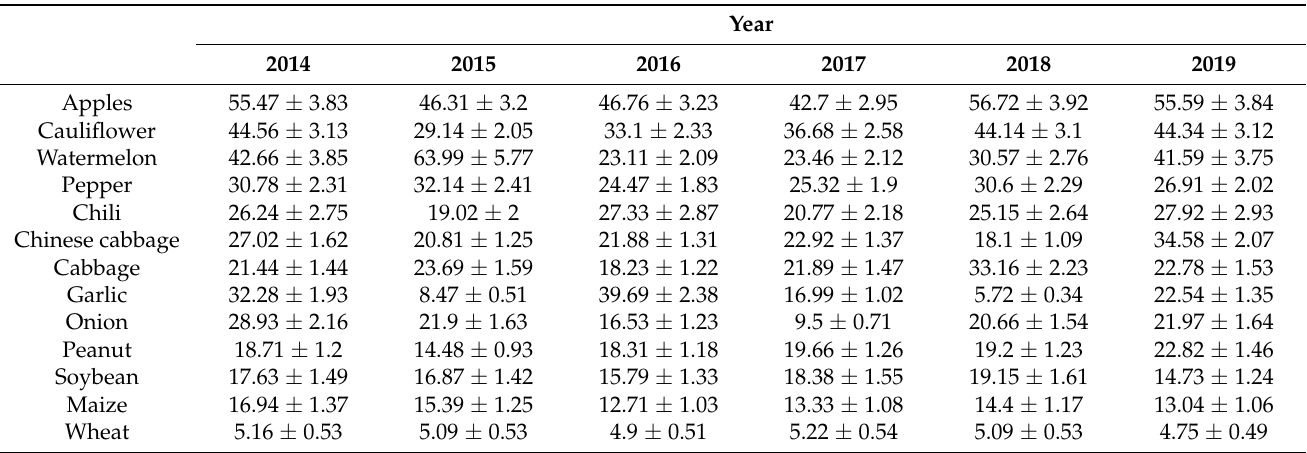
The 𝐸𝐸𝑊 𝑡 𝑈 values of different crops from 2014 to 2019 are shown in Table 5. The crop with the highest multi-year average value changed from apples to cauliflower, with a value of 26.88 ¥/m 3 , while the crop with the lowest value changed from wheat to soy- beans, with a value of 3.1 ¥/m 3 . The 𝐸𝐸𝑊 𝑡 𝑈 values of cauliflower, pepper, and apples were maintained at approximately 20 ¥/m 3 , while those of wheat, maize, and soybeans were all lower than 5 ¥/m 3 .